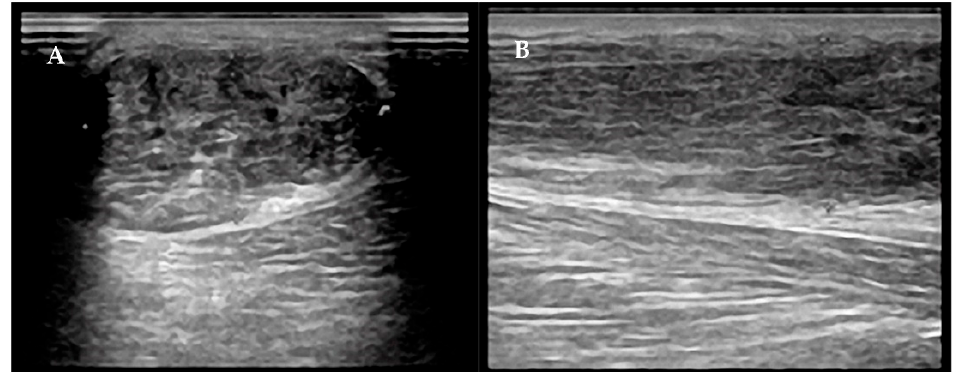
Figure 2. Transverse ( A ) and longitudinal ( B ) ultrasonographic images of the Achilles tendon after